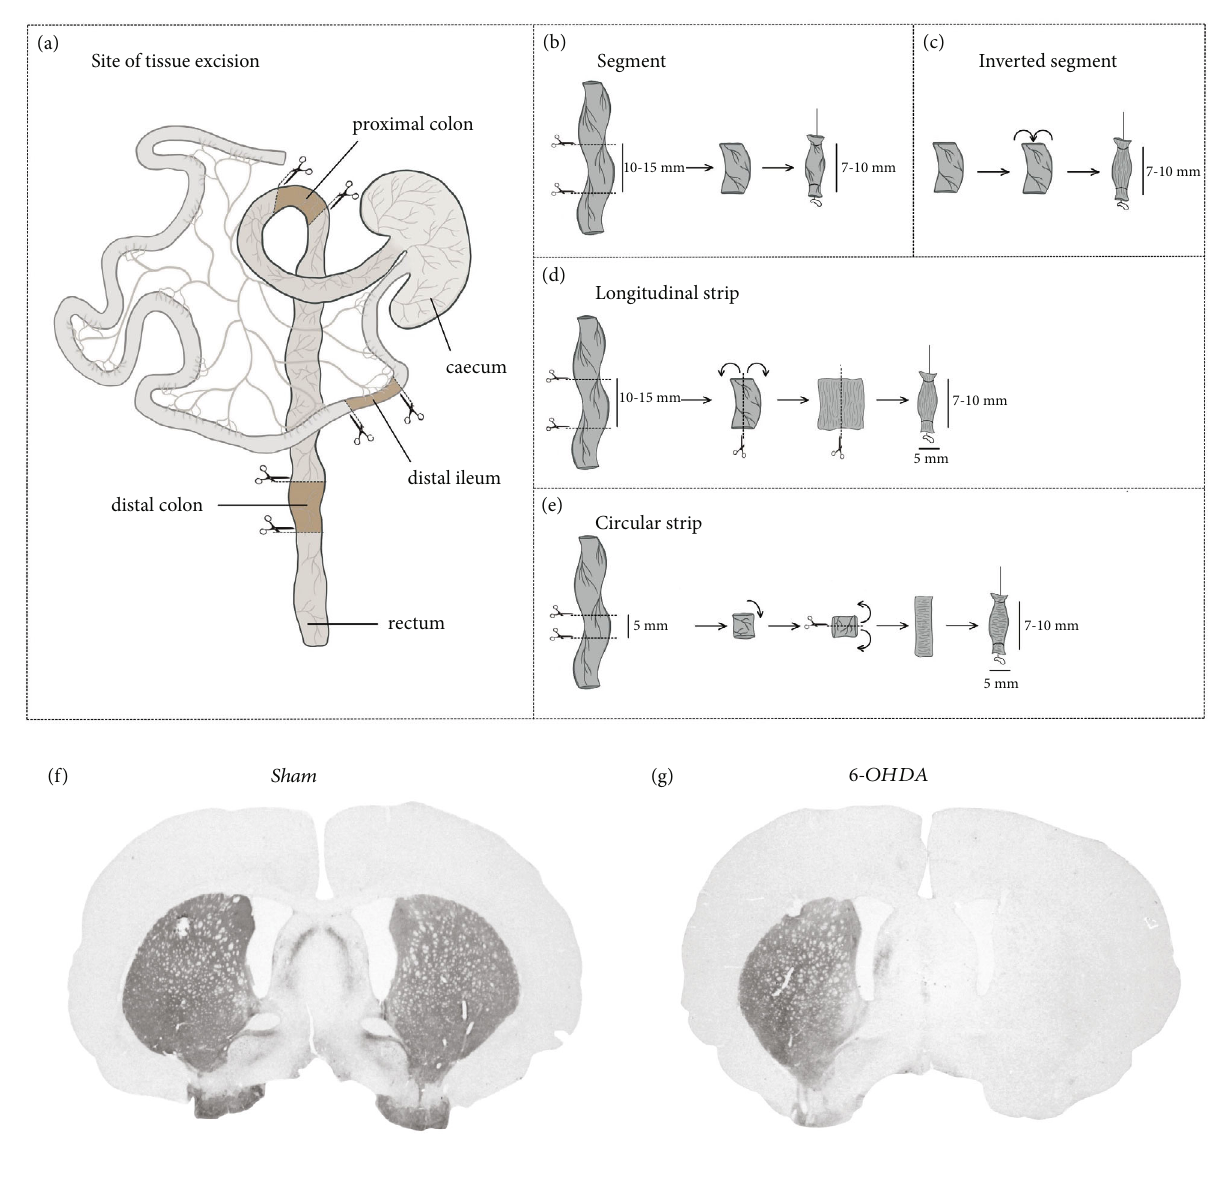
Figure 1: Tissue dissection and preparation and 6-OHDA-induced dopamine (DA) lesion. The distal colon, proximal colon, and distal ileum tissues were excised by fi rst cutting three, each 4 – 5cm long tissue pieces, from ≈ 3cm from the anus, and 3 cm from each side of the aboral and oral end of the caecum, respectively (shaded sections in a). Segments were then prepared from these 4 – 5cm long tissue pieces by further cutting ≈ 10 – 15 mm long tubes of each tissue type (scissor markings), followed by attaching a silk thread to each end closing the luminal space (b). In a subset of the ≈ 10 – 15 mm long tubes, inverted segments were created by turning the tissue inside out, exposing the luminal space but closing the mucosal space (c). The longitudinal and circular strips were also prepared from the 4 to 5 cm long tissue pieces. The longitudinal strip was prepared by cutting a ≈ 10 – 15 mm long segment, opening it up along the mesenteric line, splitting in half with a width of ≈ 5mm, and attaching a thread at each end (d). The circular strips were prepared by cutting a ≈ 5mm long segment, rotating it 90 ° , opening it up along the mesenteric line, and attaching a thread at each end (e). The saline injection (Sham) did not a ff ect the DA fi bers (f), whereas the 6-OHDA injections (6-OHDA) in the medial forebrain bundle induced an almost complete DA fi ber degeneration in the striatum